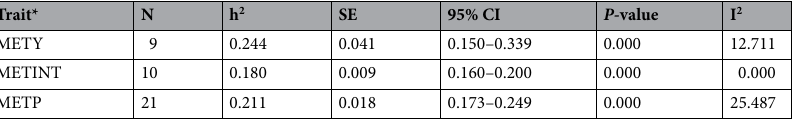
Table 3. Effect size and heterogeneity of the heritability estimates for methane emission traits of dairy cows obtained from three-level model of meta-analysis. *For traits, see Table 2.